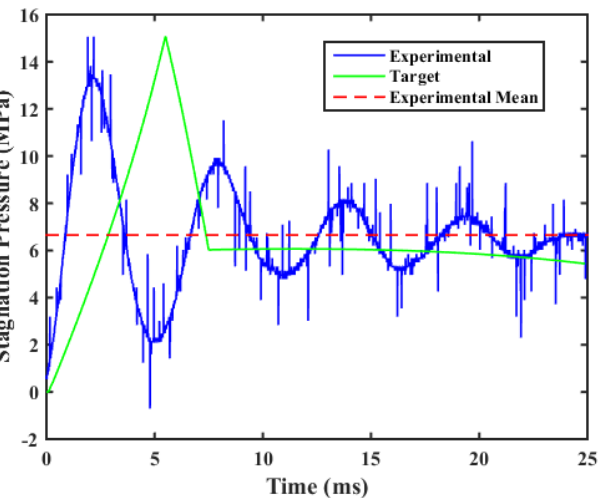
Figure 13. A sample showing the experimental and target pressure profile to illustrate the system’s ability to dynamically shape a pressure profile.